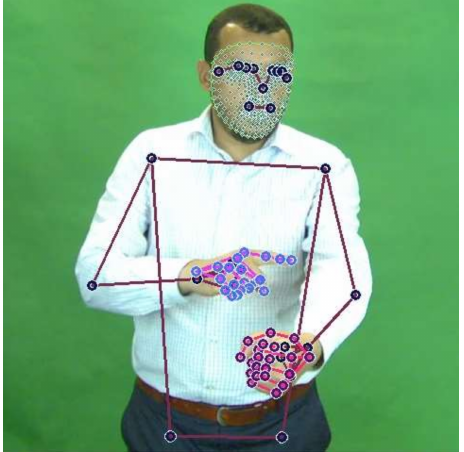
Figure 3. MediaPipe landmarks estimation